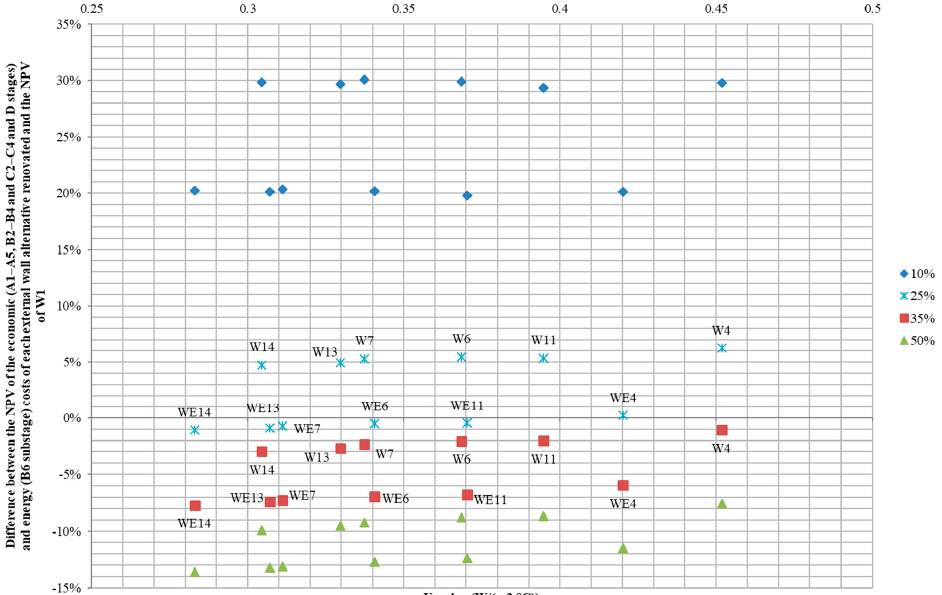
Figure 11. Difference between the NPV of the economic (A1–A5, B2–B4 and C2–C4 and D stages) and energy (B6 substage) costs of each external wall alternative renovated and the NPV of W1, considering different consumption patterns for the use stage (guaranteeing 10%, 25% or 35% or 50% of the energy needs) and considering the corresponding U-values.